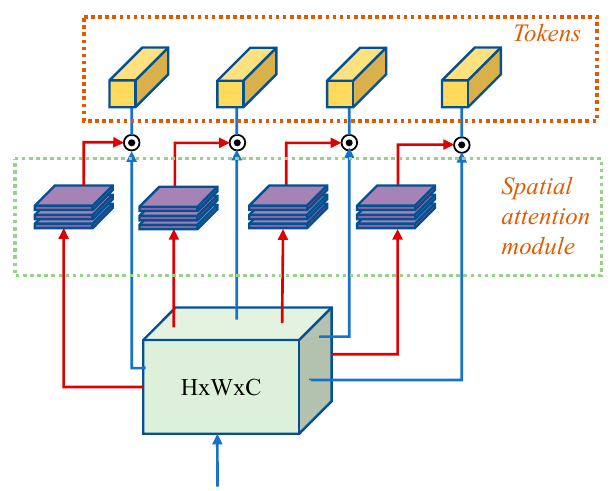
Figure 4. TokenLearner calculation flow.